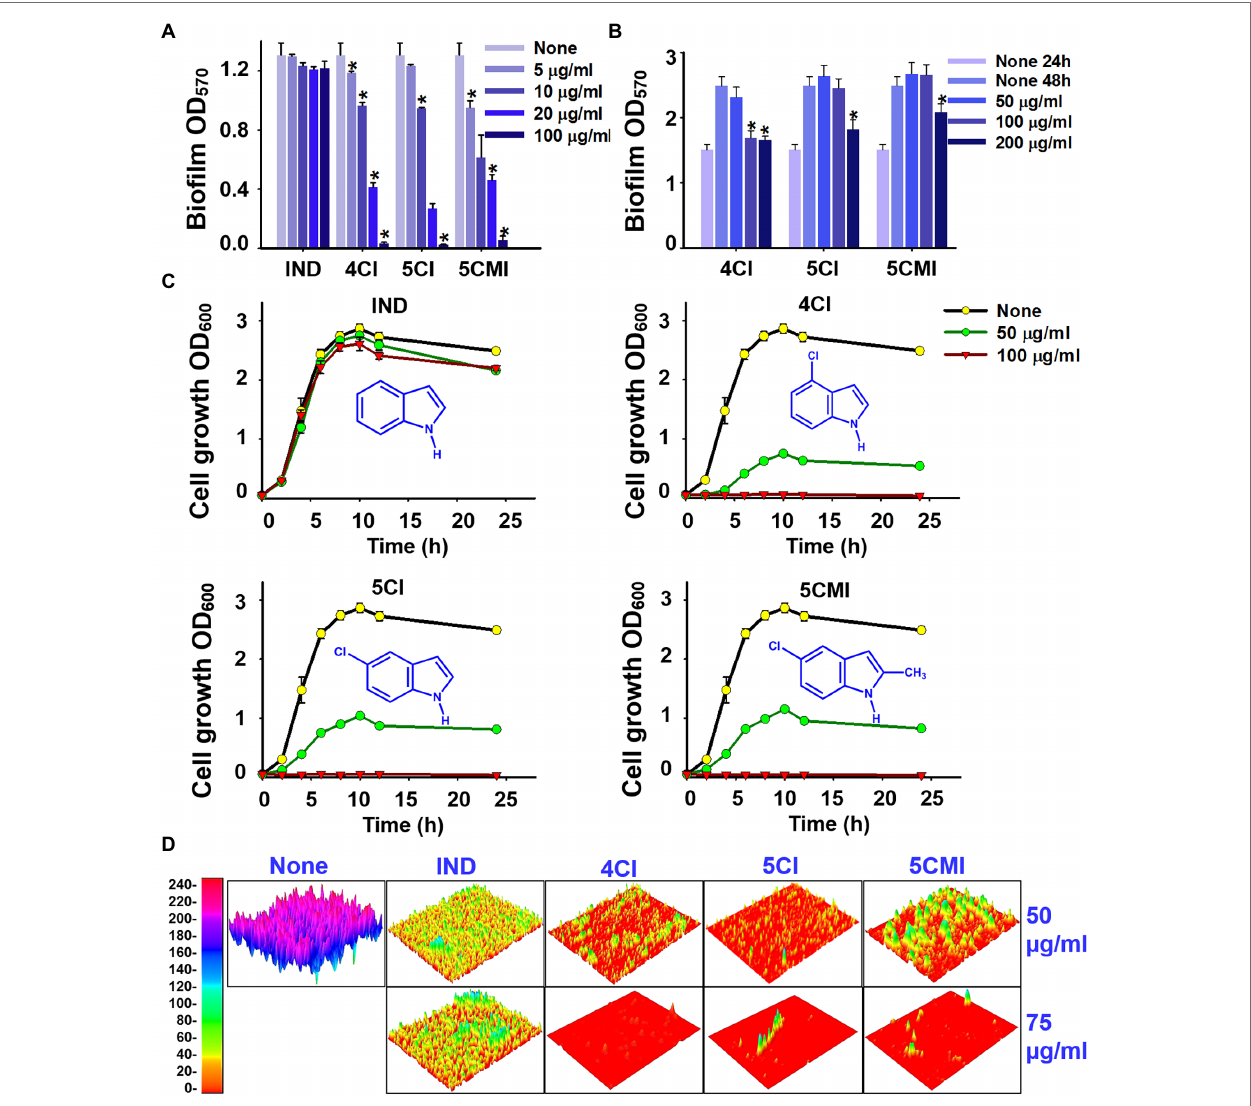
FIGURE 1 | (A) Crystal violet quantification of biofilm formation in UPEC in the presence of indoles, wherein biofilm OD 570 represents absorbance of CV-stained biofilm, (B) crystal violet biofilm dispersal assessment of UPEC in the presence of indoles, wherein biofilm OD 570 represents absorbance of CV-stained biofilm, (C) cell growth curves of UPEC in the presence of indoles, and (D) 3D representation of UPEC biofilms in the presence of select indoles at concentrations 50 and 75 μ g/ml. * p < 0.05 vs. non-treated